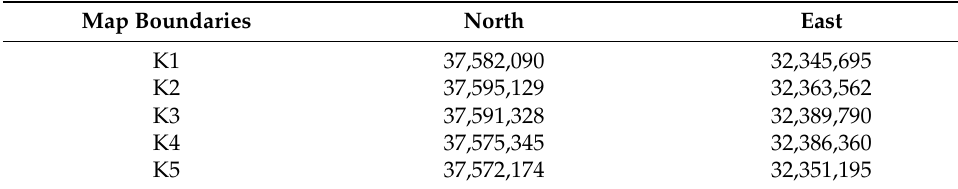
Table 1. Measuring zone mapping boundary